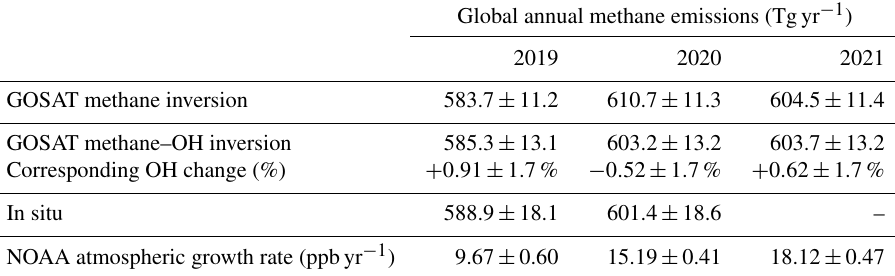
Table 1. Global annual emission estimates of methane (Tgyr − 1 ) inferred from GOSAT (2019–2021) and in situ (2019–2020) atmospheric measurements of methane. The annual atmospheric methane growth rate (ppbyr − 1 ) for 2019 to 2022 reported by NOAA is also shown.